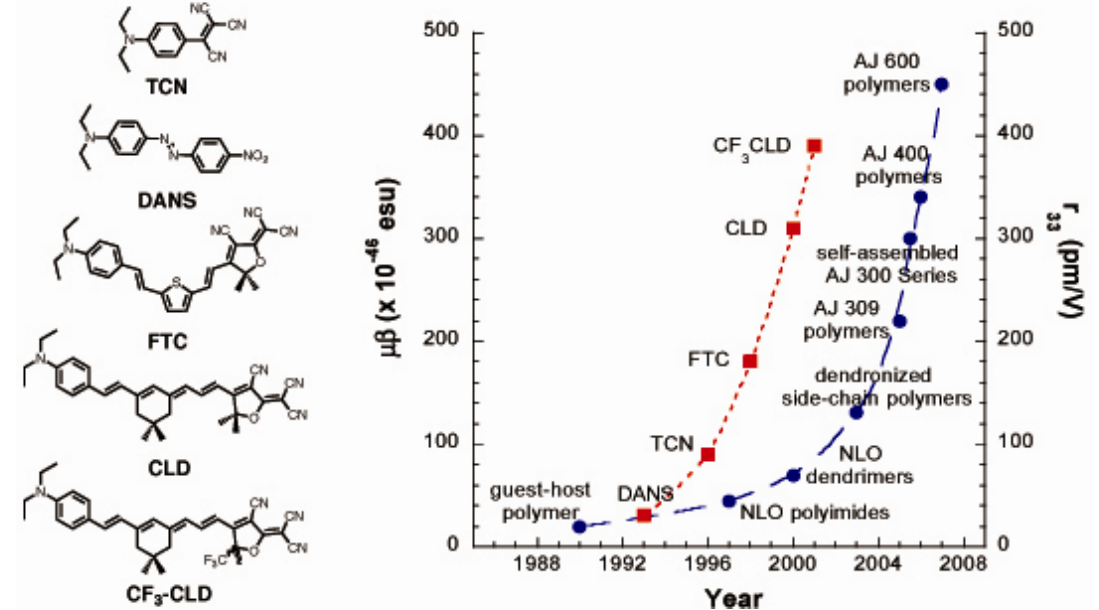
Figure 2. The chronological variation of the product of chromophore first hyperpolarizability ( β ) and dipole moment ( μ ) is shown in red (dotted line) while the variation of electro-optic activity (r ) is shown in blue (dashed line). Adapted from 33 reference [8] with permission of the American Chemical